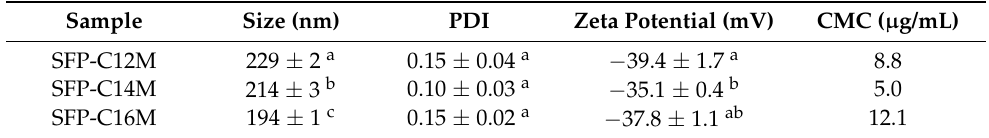
Table 3. Properties of the SFP nanomicelles. The results are the means ± SD ( n = 3), letters a, b, c in the same line represent a significant difference at p < 0.05.